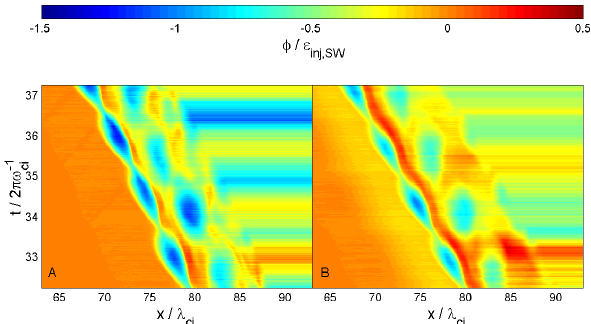
Fig. 3. Spatial cross section of the simulation in the shock region at t = 34 . 5 × 2 πω − 1 . The top panel (panel 1) shows perpendicular ci magnetic field strength, B z , normalised to the upstream value, B z, 1 . Panel 2 shows φ = R E x dx normalised to the solar wind proton in- jection energy E inj , SW . Panels 3 and 5 show the energies of the pickup protons and the solar wind protons, respectively, again nor- malised to E inj , SW . Panels 4 and 6 show the pickup and solar wind proton x -velocities, normalised to the injection velocity v inj . tons move upstream to form a relatively energetic